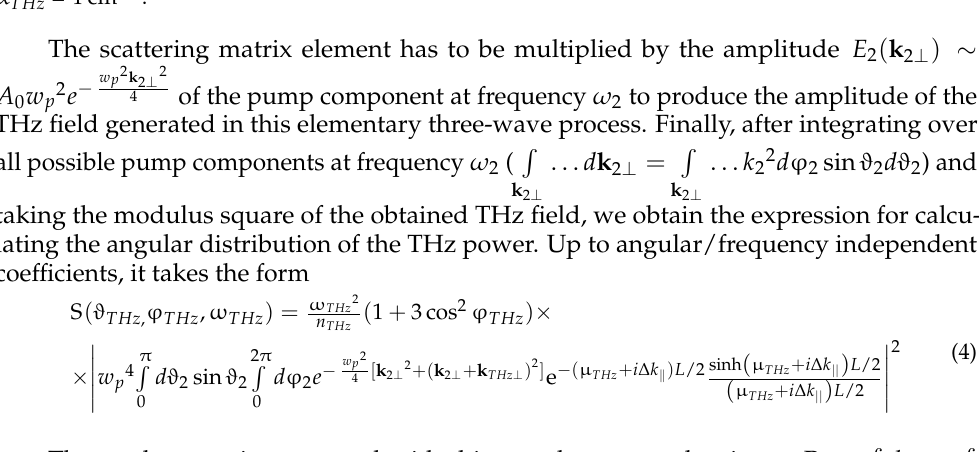
S ( ϑ THz , ϕ THz , ω THz ) sin ϑ THz d ϑ THz [26]. Figure 1b shows an example of the power density parameters of congruent lithium niobate crystal with 7.1 mol.% of Mg doping impurity were w p = 100 µ m and did not take into account the crystal absorption, α THz = 0. Figure 1c